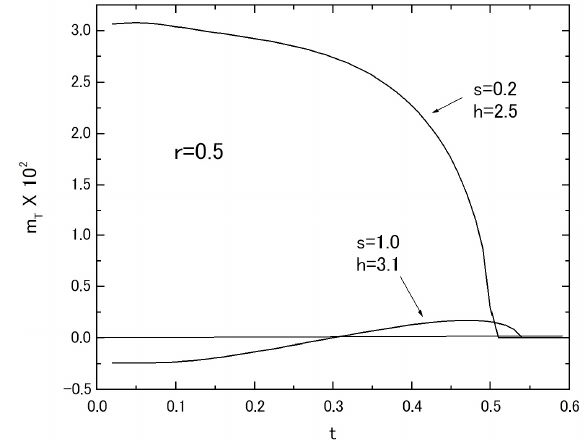
Figure 10. The thermal variations of m T in the system with r = 0 . 5 are given, when the two set values ( s and h ) are selected as ( s = 0 . 2 and h = 2 . 5) and ( s = 1 . 0 and h = 3 . 1).